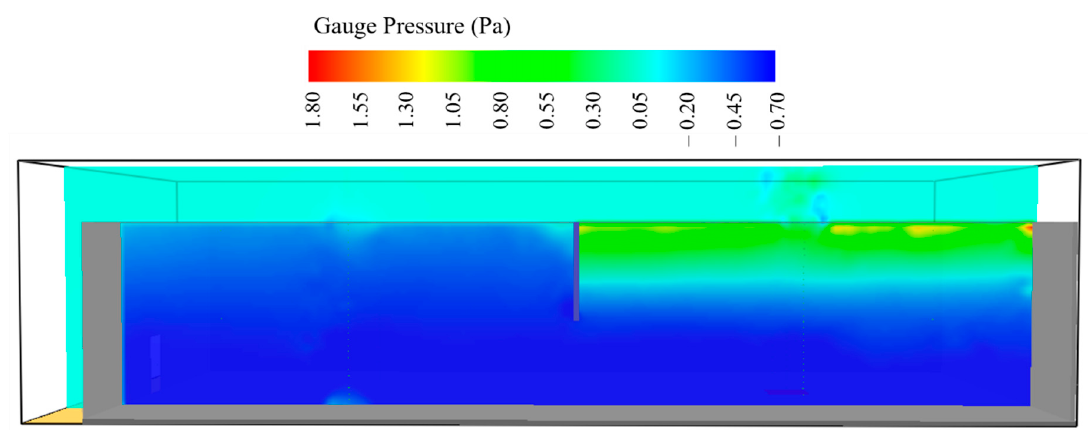
Figure 11. Pressure field in a plane that crosses two exhaust vents (y = 3.75 m) at time t = 600 s (case 9).